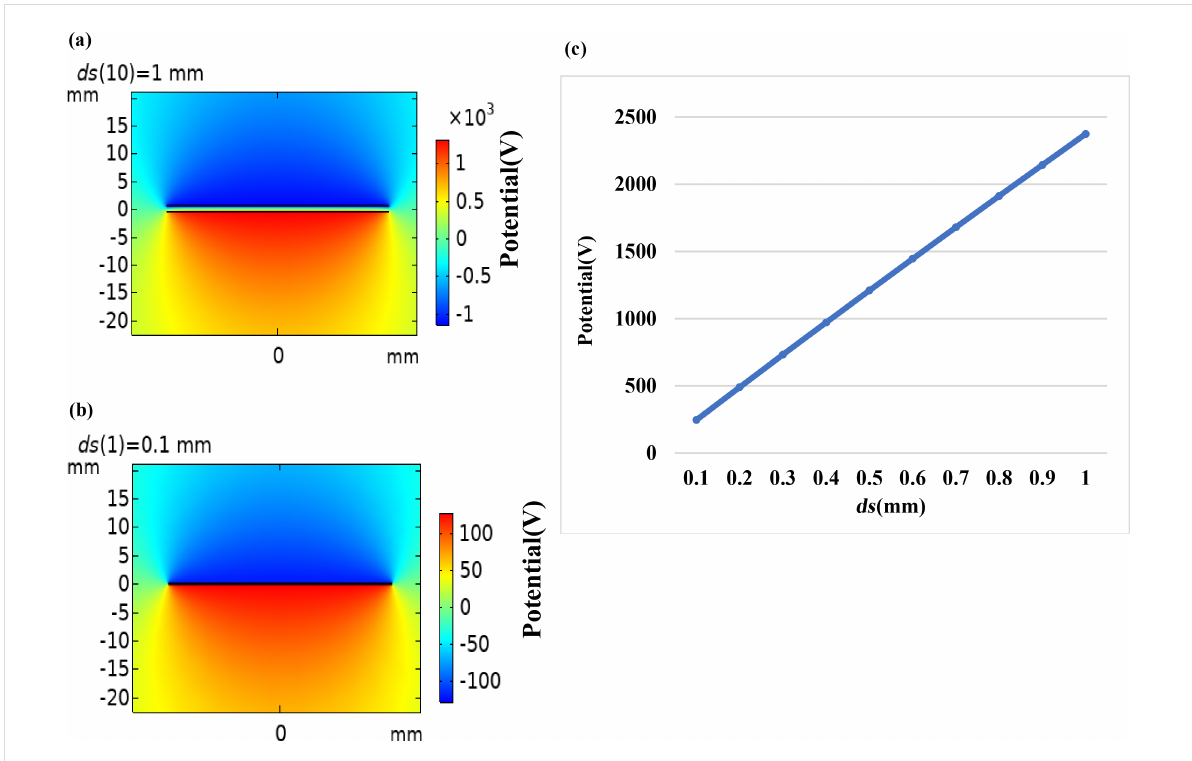
Figure 3: Simulation diagram for (a) ds = 1 mm and (b) ds = 0.1 mm. (c) Potential difference between the outer surfaces of the upper and the lower triboelectric materials as a function of ds .